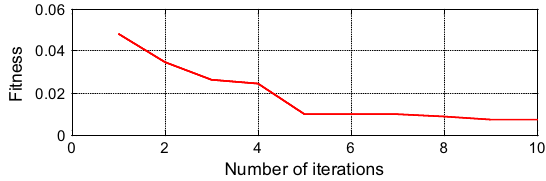
Fig. 15 Fitness value of global optimal solution via iteration